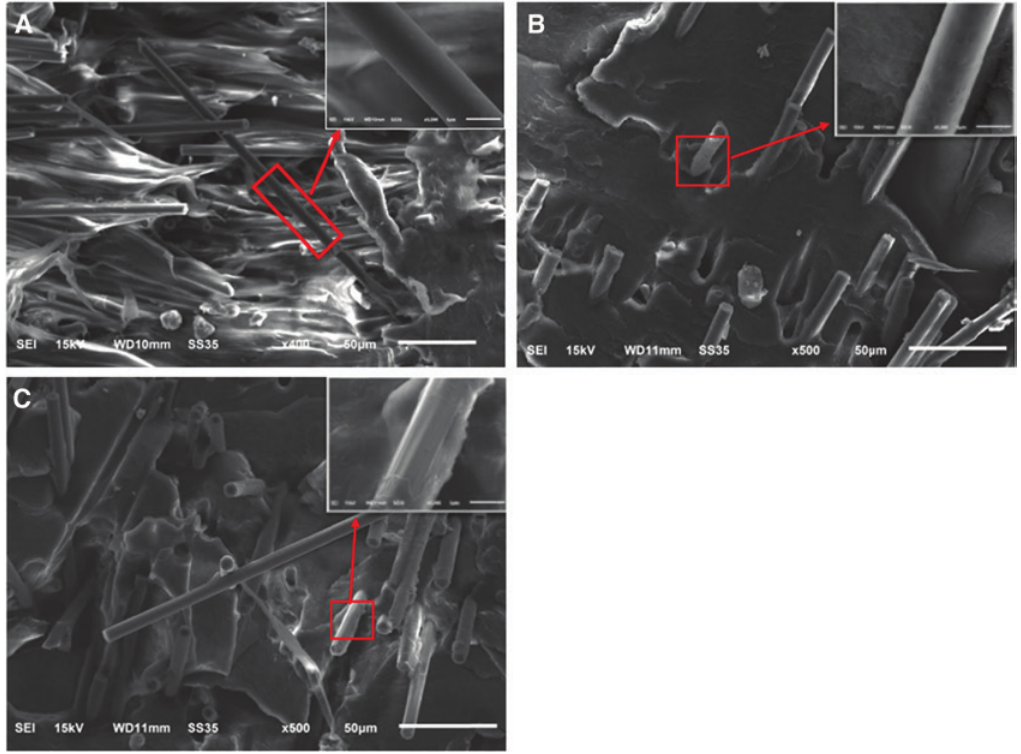
Figure 5: SEM micrographs of the LDPE/EVA/CF containing 15 wt% CF with different LDPE/EVA mass ratios: (A) LDPE/EVA = 100/0; (B) LDPE/ EVA = 80/20; (C) LDPE/EVA.